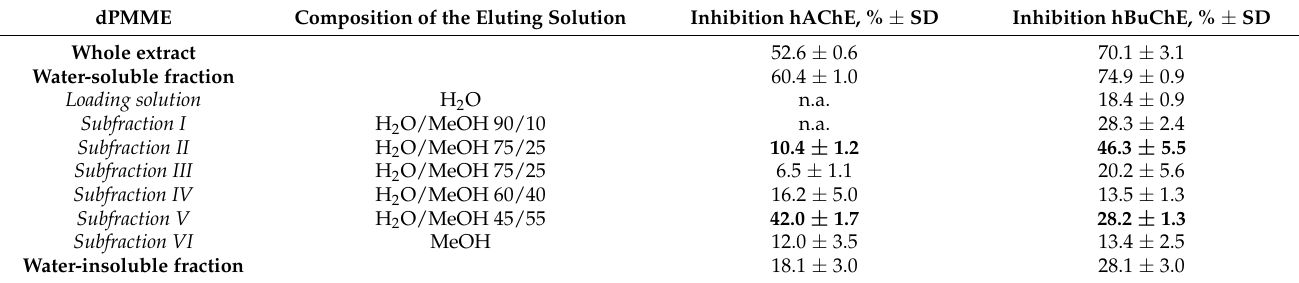
Table 2. Inhibitory activity of Subfractions I–VI obtained by SPE separation from the water-soluble fraction of dPMME towards human cholinesterase enzymes. Activity of the whole dPMME extract and water-insoluble fractions are also listed.